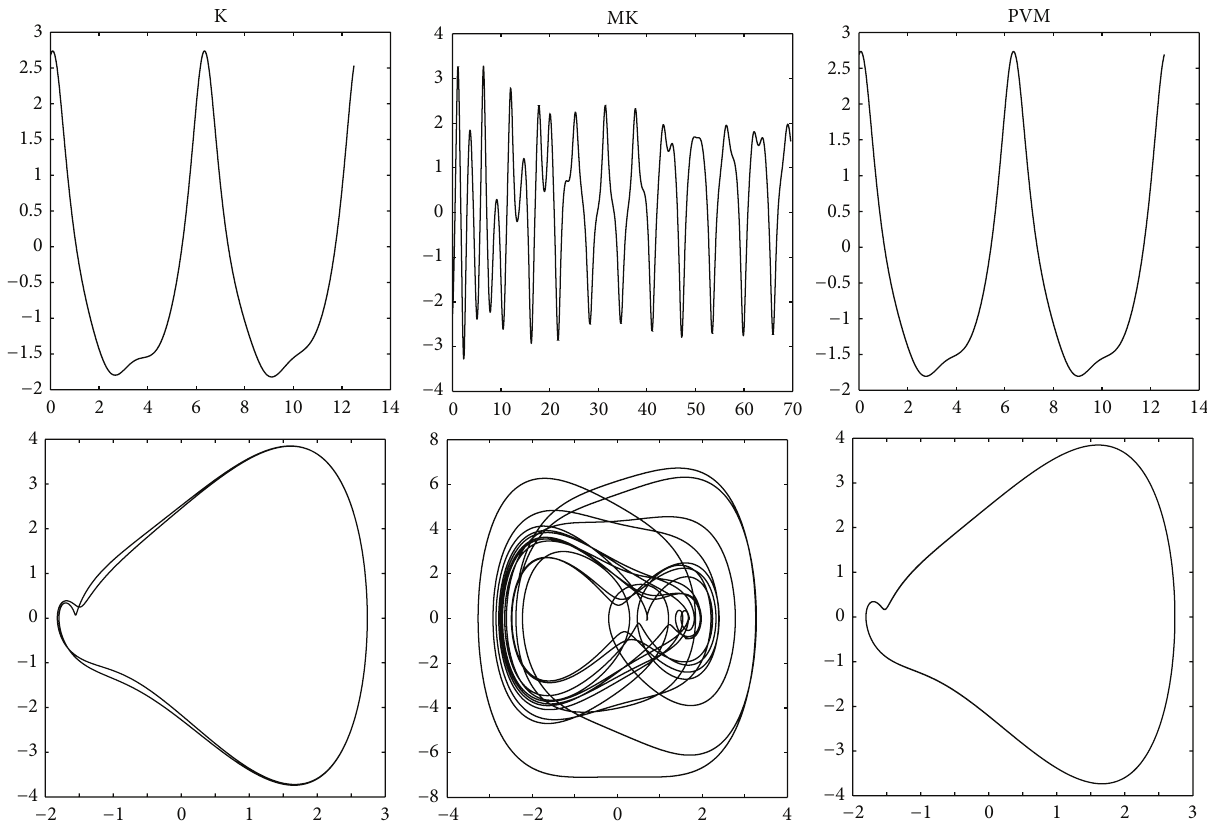
Figure 2: These results show the numerical solutions on [ 0,4𝜋 ] (top panels) and the trajectories in the phase planes (bottom panels) simulated by Kub´ıˇcek’s approach, MK, and PVM are shown from left to right panels, respectively.